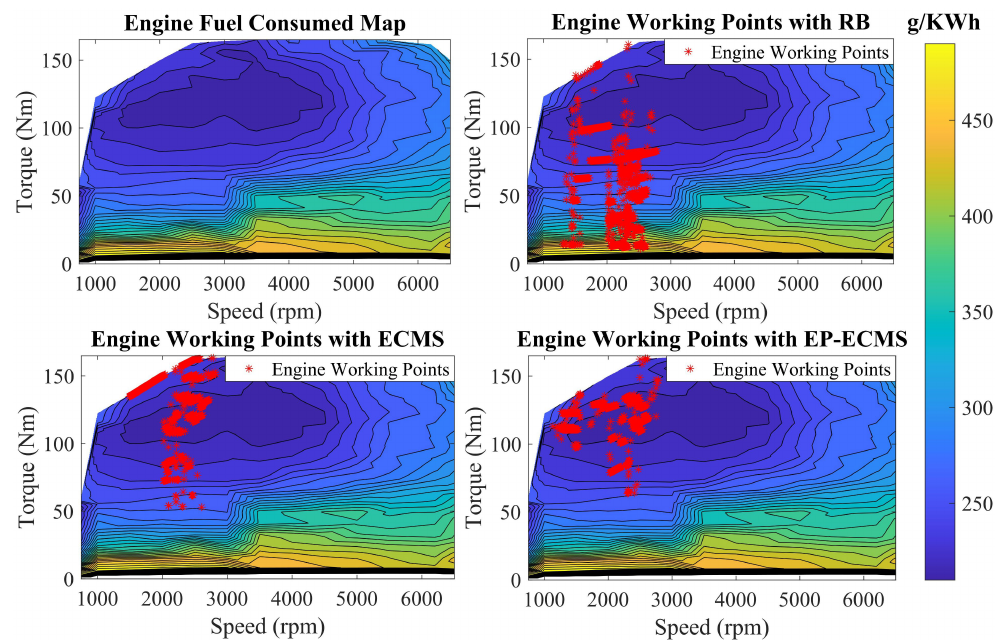
Figure 13. The engine working point in the efficiency